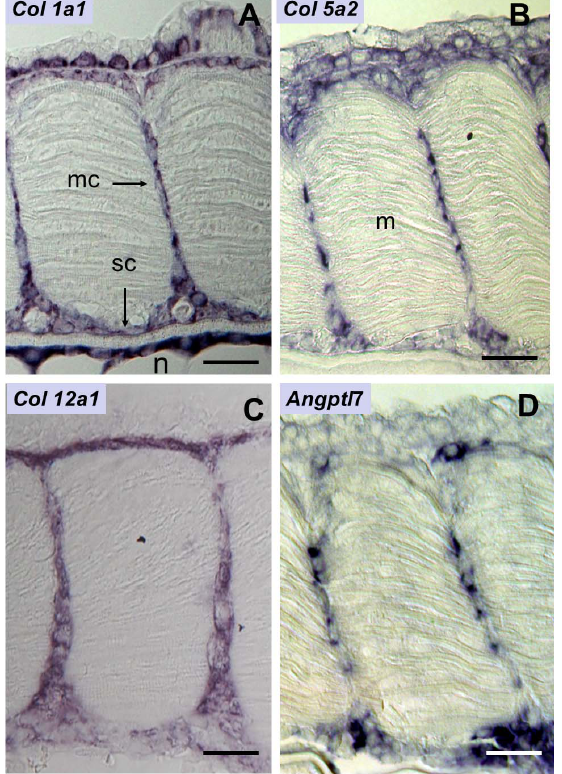
Figure 3. Myoseptal cells express genes involved in extracel- lular matrix production and remodelling. ( A – D ) Frontal sections of eyed stage (17 dpf) embryos. Expression of ( A ) col1a1 , ( B ) col5a2 , ( C ) col12a1 and ( D ) Angiopoietin-7 like. mc: myoseptal cell; sc: skeletogenic cells; m: myotome; n: notochord. Scale bars, 20 m m.